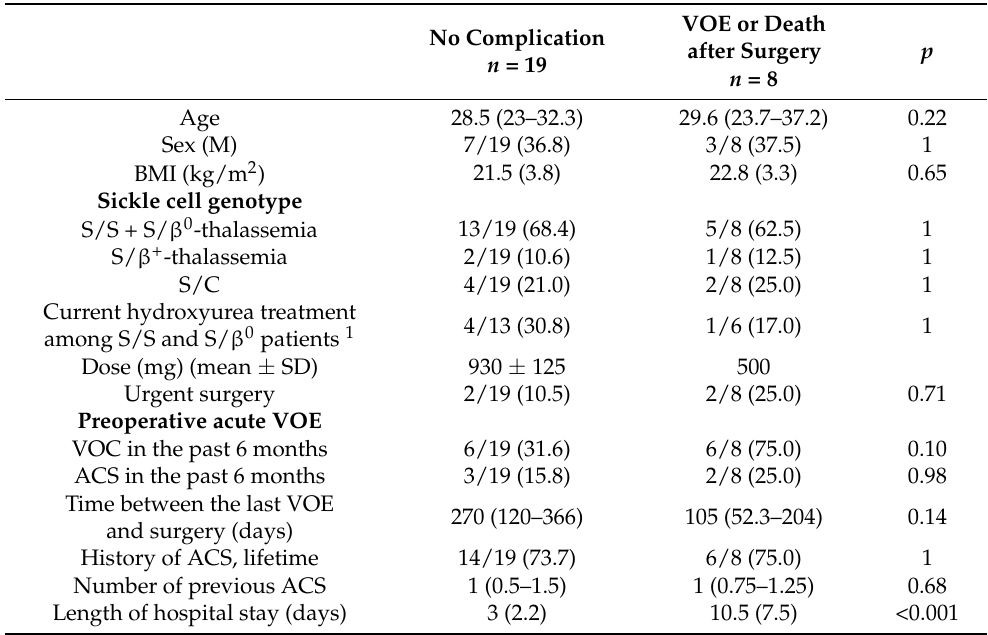
Table 3. Characteristics of patients without prophylactic transfusion according to the occurrence of postoperative